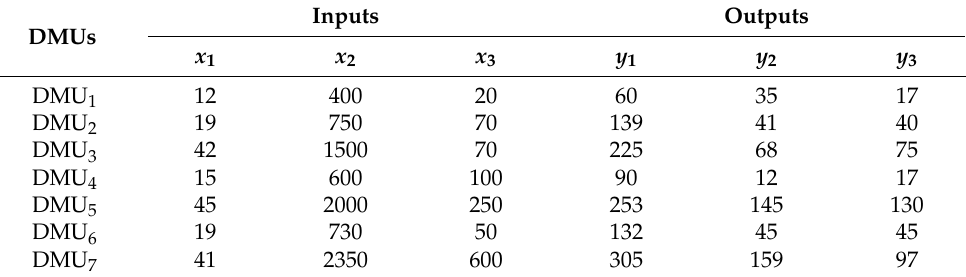
Table 1. Data drawn from [27].